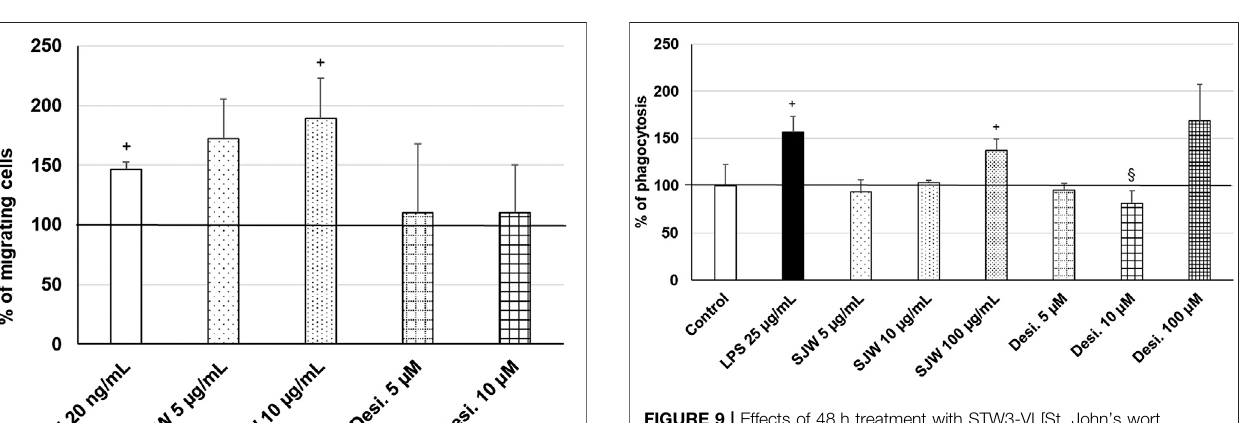
FIGURE 9 | Effects of 48 h treatment with STW3-VI [St. John ’ s wort (SJW], desipramine (desi.), or lipopolysaccharide as positive control and afterwards for 24 h with FBS-coated FITC- fl uorescent microspheres, on phagocytic capacity of mouse SIM-A9 microglia. Quanti fi cation of phagocytosis/DAPI in % of untreated control (100%) expressed as mean + SEM; signi fi cance (by T-TEST): + p ≤ 0.05 vs. untreated control; § p ≤ 0.05 vs. SJW 100 µg/ml; n (cid:2) 3 ‒